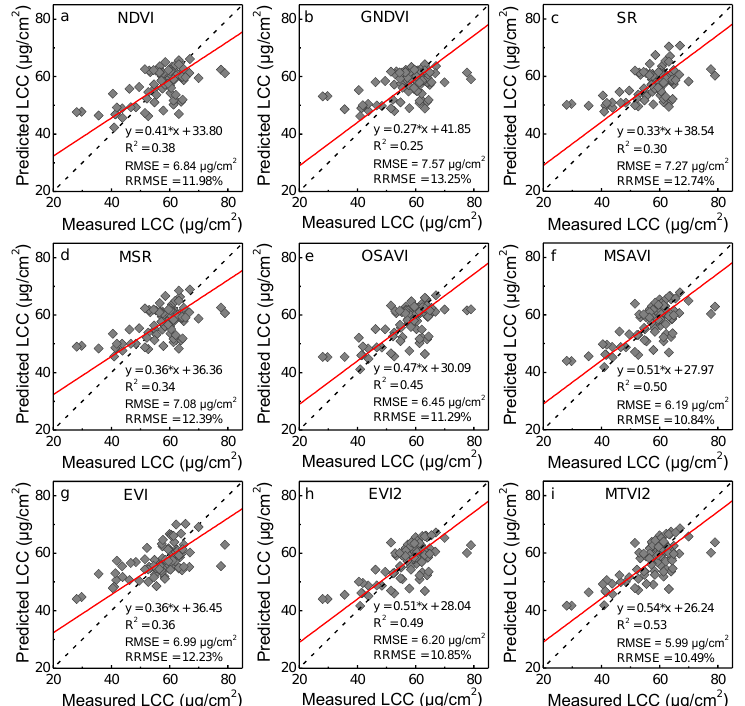
Figure 3. Cross-validation results of different VIs for LCC assessment. ( a ) – ( i ) are results for NDVI, GNDVI, SR, MSR, OSAVI, MSAVI, EVI, EVI2, and MTVI2, respectively.